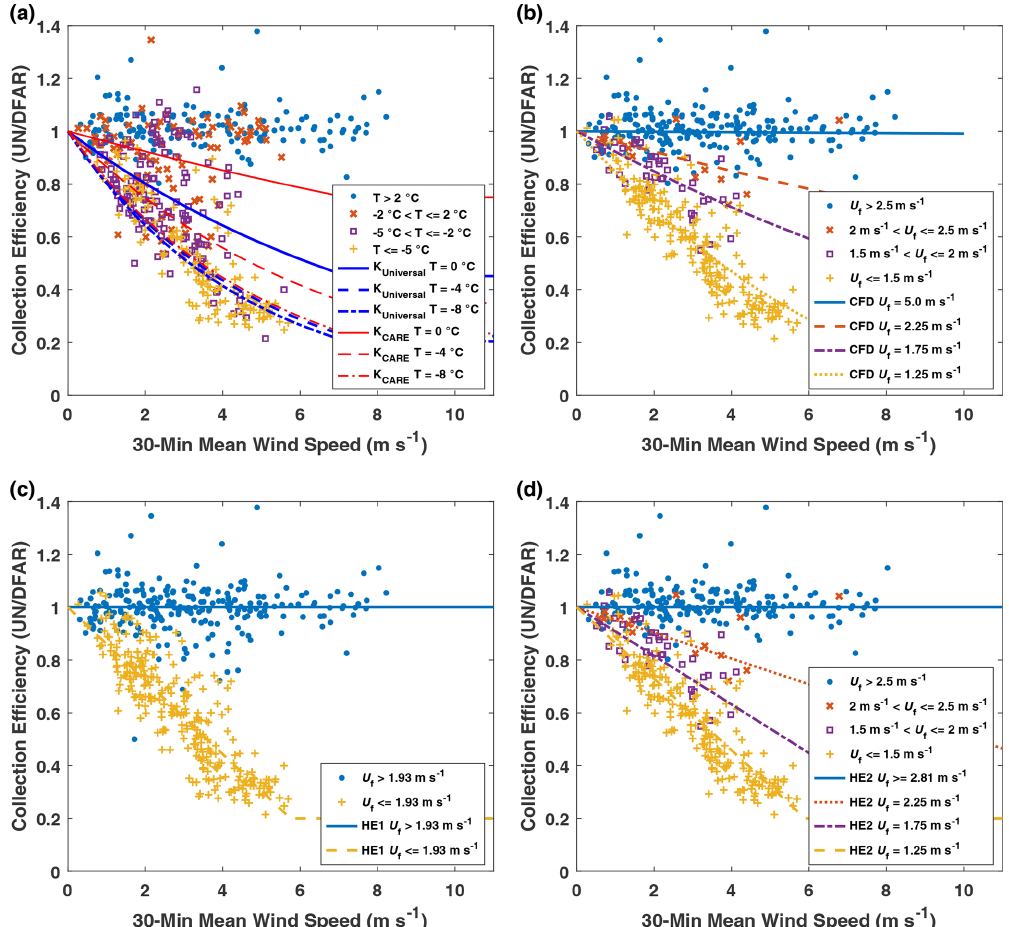
Figure 6. Collection efficiency of unshielded gauge as a function of wind speed for (a) mean air temperature T categories for the K Universal and K CARE transfer functions, (b) mode fall velocity U f_mode categories with the CFD transfer function, (c) mean fall velocity U f_mean categories for the HE1 transfer function, and (d) mode fall velocity U f_mode categories with the HE2 transfer function. Table 3. Unshielded gauge 30min event bias error (BE), root mean square error (RMSE), correlation coefficient ( r ), and number of events ( N ) for collection efficiency and precipitation accumulation between the unshielded and reference DFAR shielded Geonor T-200B3 gauge for unadjusted comparison, K Universal transfer function with wind speed and air temperature dependence, K CARE transfer function with wind speed and air temperature dependence, present study CFD transfer function with wind speed and mode fall velocity dependence, HE1 transfer function with wind speed and mean fall velocity dependence, and HE2 transfer function with wind speed and mode fall velocity dependence. Statistics are based on the comparison of experimental results from the CARE site between 1 November and 30 April 2013/14 and 2014/15. Collection efficiency Precip. accum.